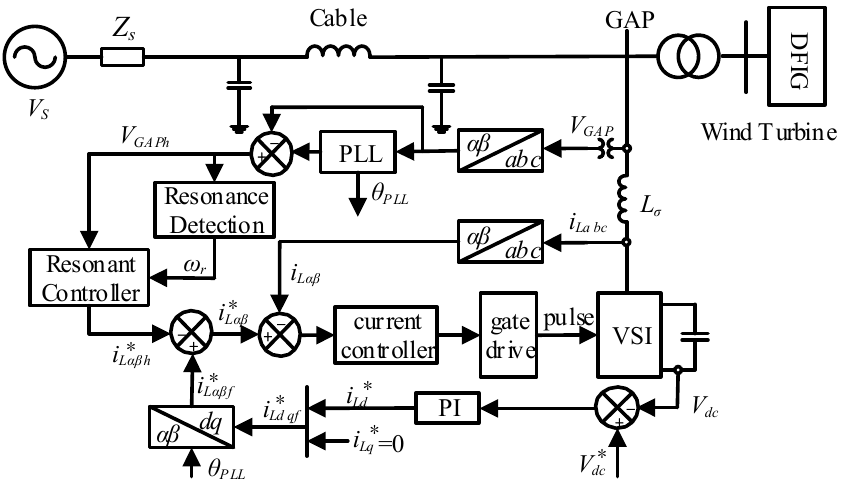
Figure 9. Control block diagram of selective harmonic damping method.